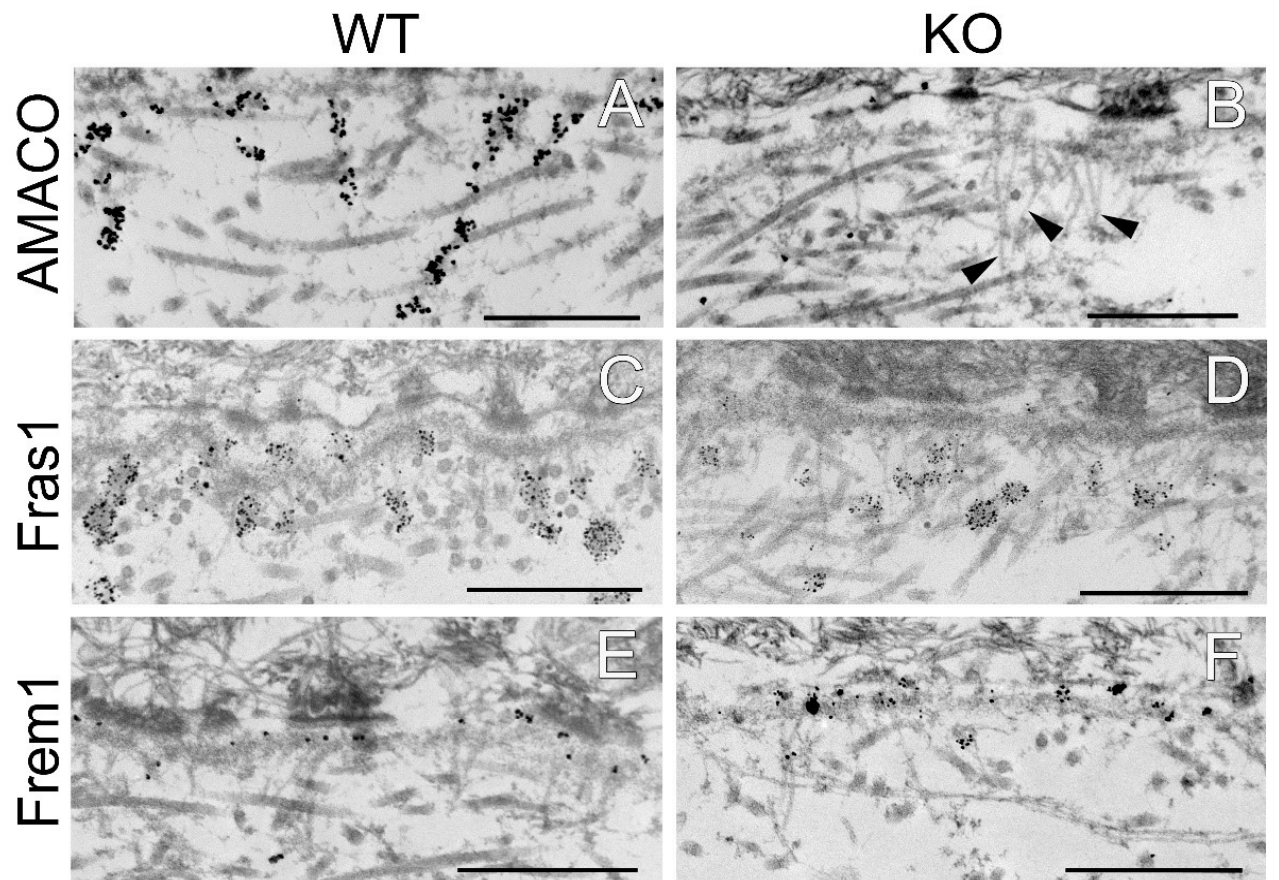
Figure 5. Immunogold electron microscopy analysis of the dermal–epidermal junction in AMACO- deficient newborn mouse skin. ( A ) An AMACO guinea pig antibody directs immunogold to anchor- ing cords, which insert into the subepithelial basement membrane and extend into the dermis. ( B ) Labeling for AMACO is absent in AMACO-deficient mice skin, however anchoring cords are clearly present (arrows). ( C , E , G , I ) Fras1, Frem1, Frem2, and nephronectin rabbit antibodies detect anchor- ing cords with a similar distribution as in AMACO-deficient skin ( D , F , H , J ). Scale bars = 500 nm. 3. Discussion 3.1. Genetic Studies of AMACO and Fraser Complex Protein Function